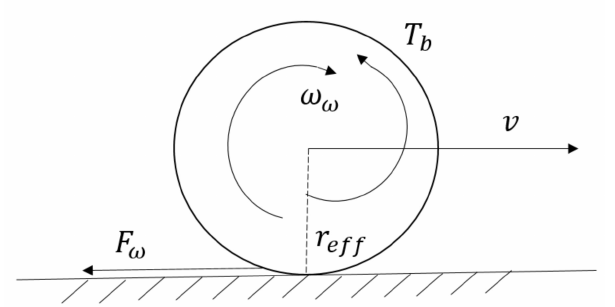
Figure 1. Quarter-vehicle model.